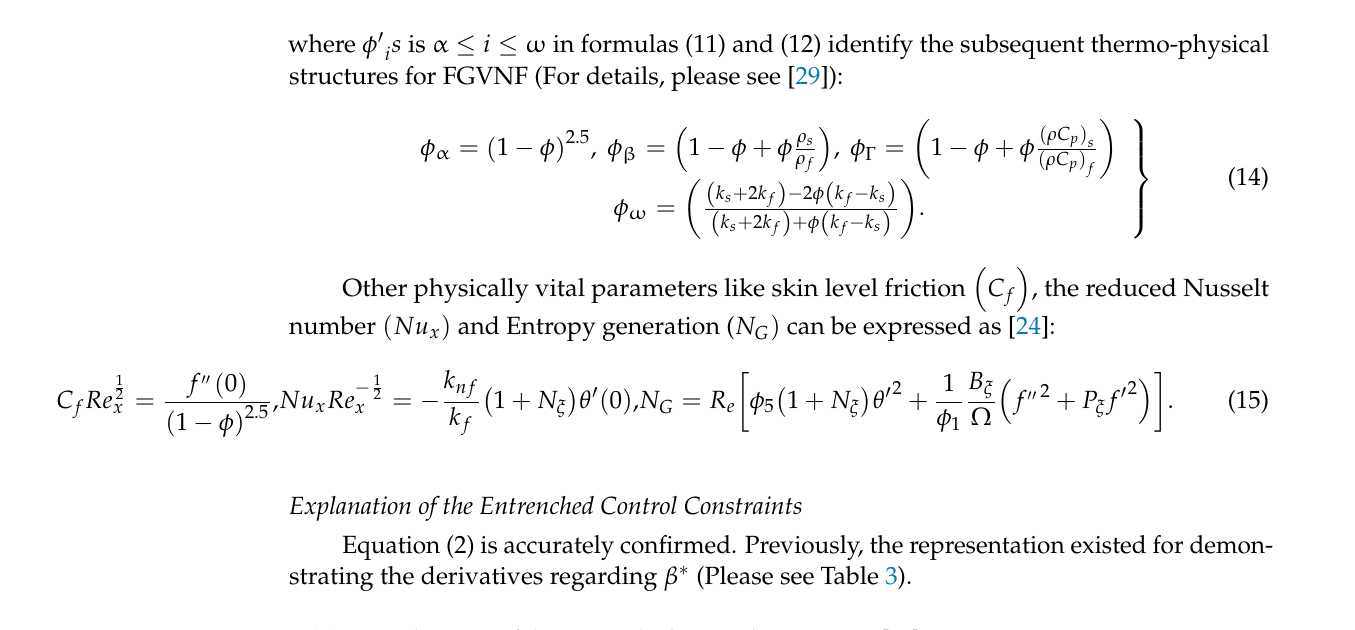
Table 3. Explanation of the Entrenched Control Constraints